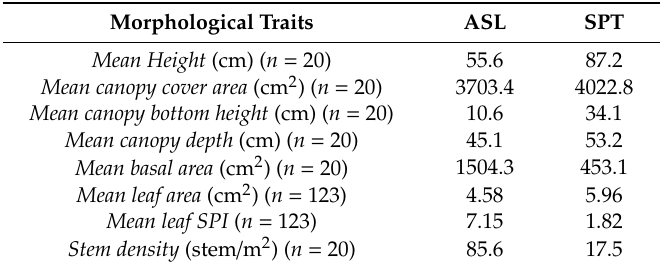
Table 2. Plant morphological traits of ASL and